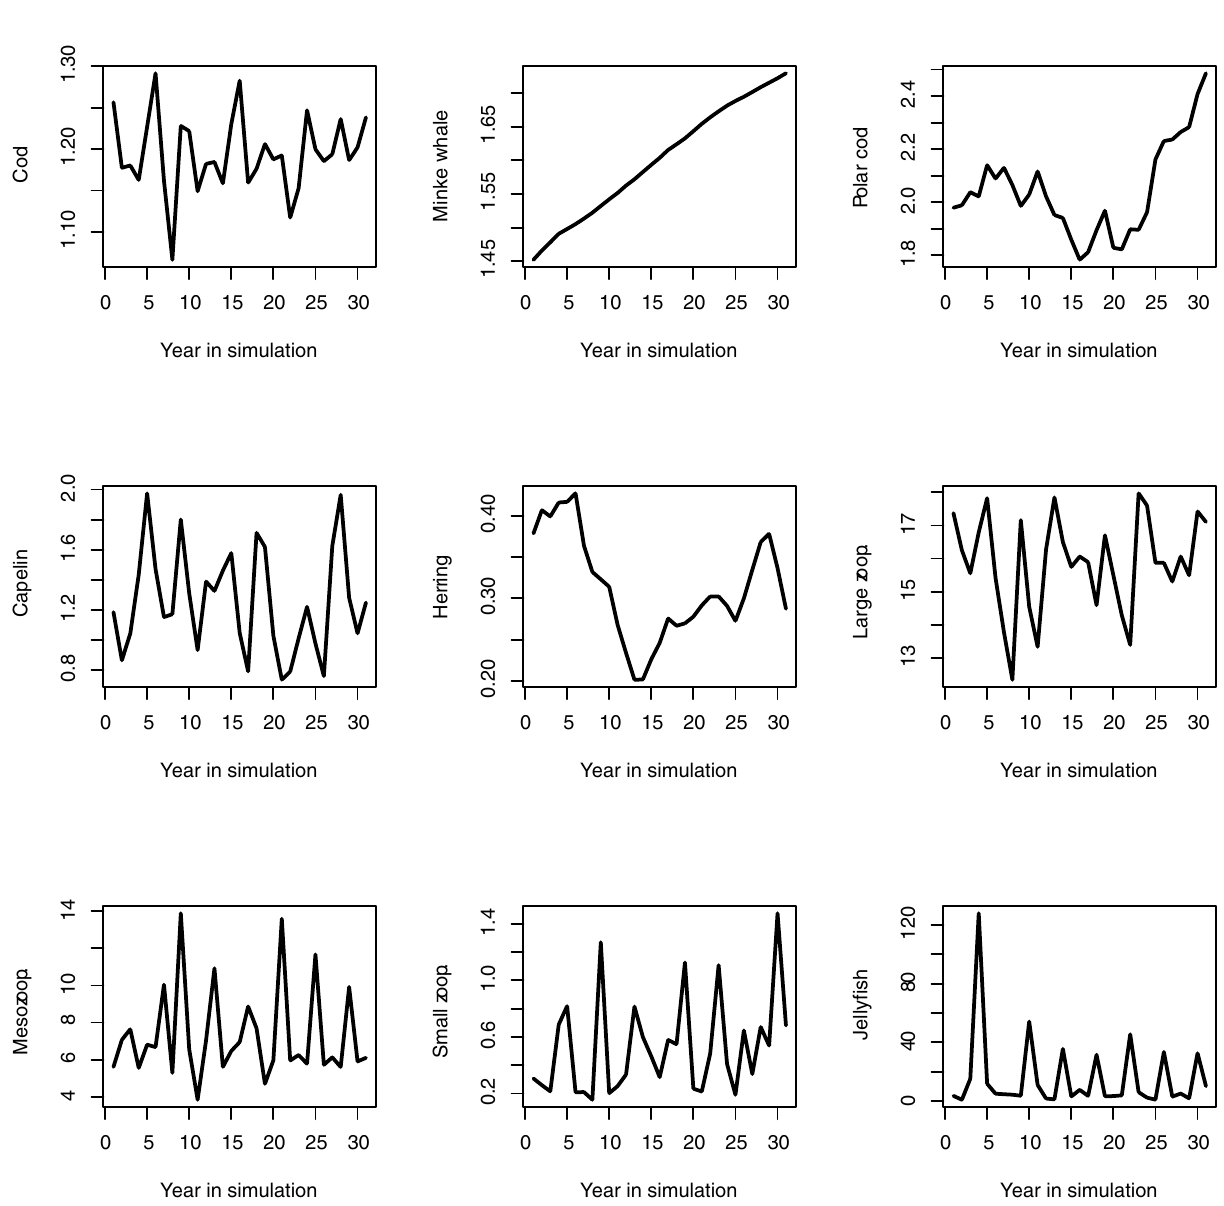
Fig 4. Development of biomass in key species. Relative change in biomass of key species in control run compared to initial values.